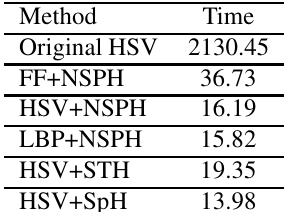
Table 1. The time cost(ms) of the two